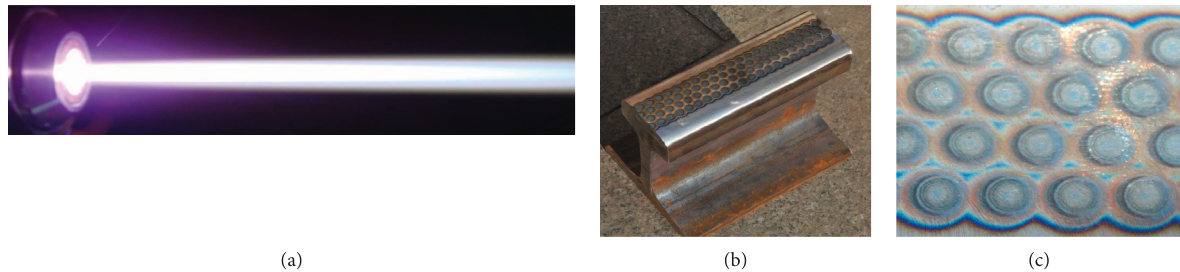
Figure 1: The laminar plasma hardening technique: (a) laminar plasma jet; (b) rail treated with the laminar plasma hardening technique; (c) close-up of laminar plasma hardening